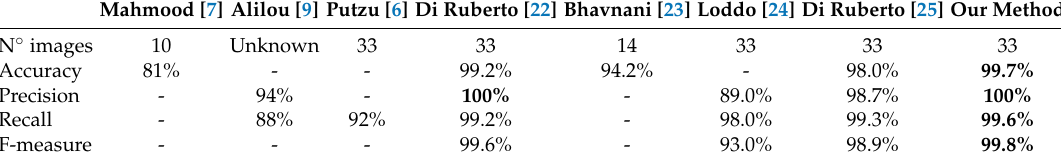
Table 1. WBC counting performances compared with the state-of-the-art. Di Ruberto’s work [25] was tested on the entire ALL-IDB. The column for this work indicates the results obtained on the first 33